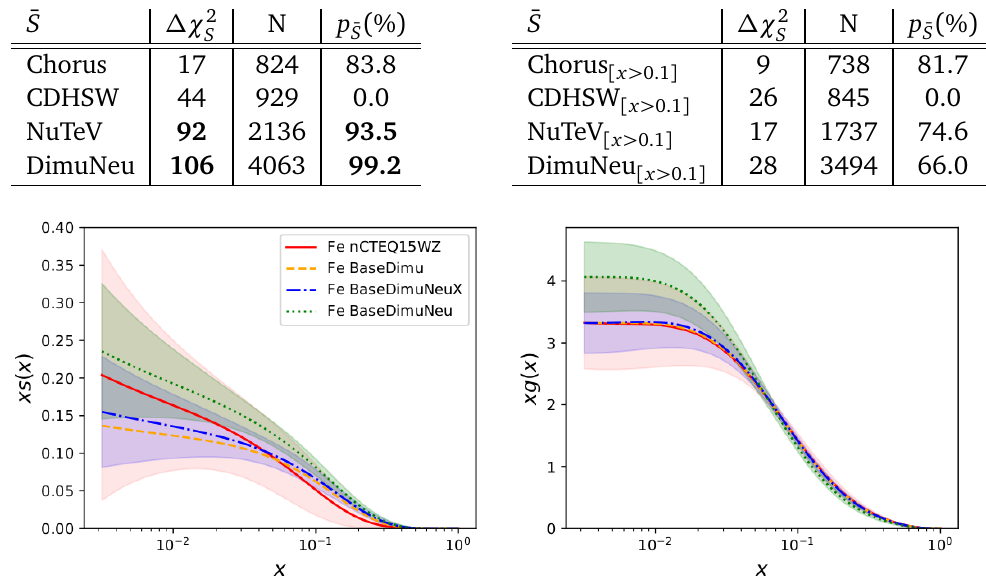
Table 1: ∆ χ 2 and the percentiles p ¯ S including the ¯ S neutrino data sets.